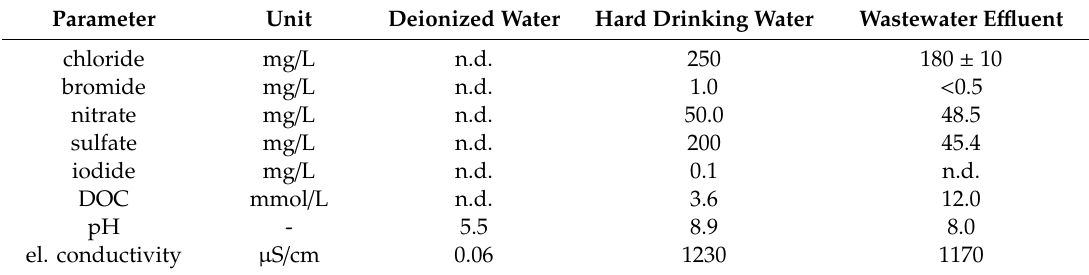
Table 1. Concentrations of the water constituents and measured parameters in the water matrices. Parameter